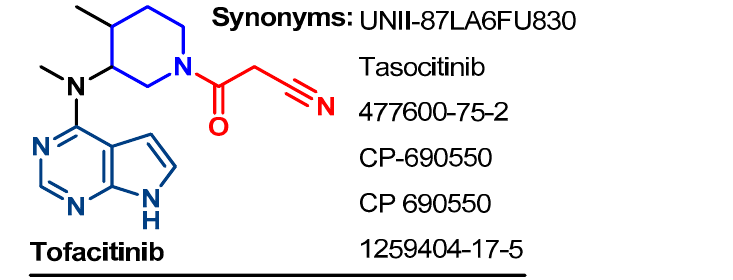
Figure 59. Kinase inhibitory activity of tofacitinib. On the other hand, the inhibitory activity of tofacitinib against JAKs was also evalu- ated by Clark et al. [83]. The results of that study revealed its inhibitory activity against JAK3 at IC 50 of 55 nM. In addition, tofacitinib inhibited the enzymatic activity of JAK1 and JAK2 at IC 50 values of 15.1 nM and 77.4 nM, respectively.